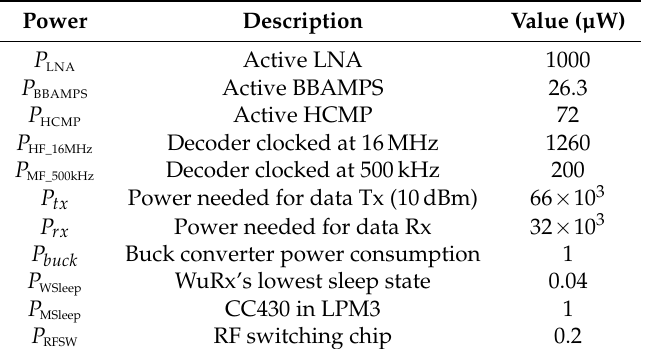
Figure 14. A sensor node prototype embedded with the WuRx (46.3 × 24.5 mm). SLD, square-law detector. Table 1. Sensor node power parameters. HCMP, hysteresis comparator; LPM3, Low-power Mode